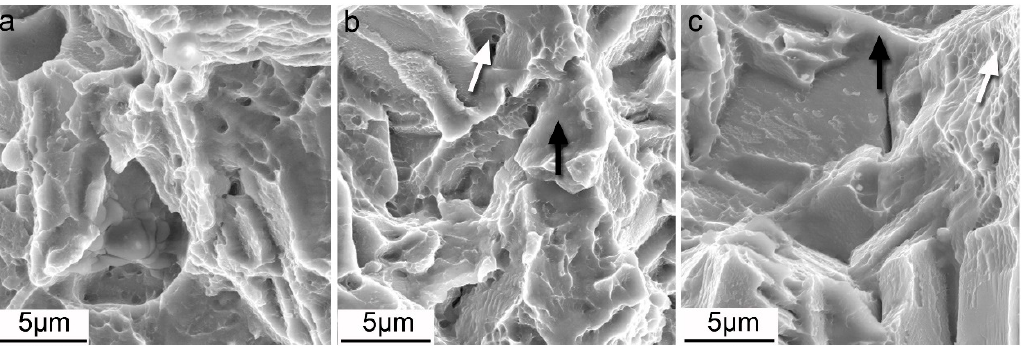
Figure 8. Fracture surfaces different samples: ( a ) AE; ( b ) F-7; ( c ) F-12.